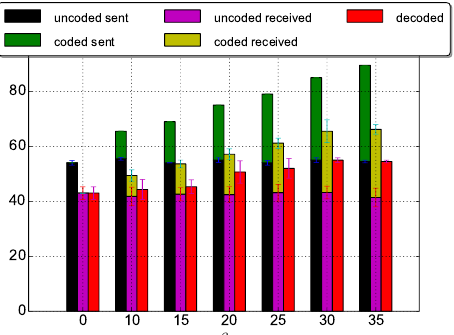
Figure 14. Decoding performance. The decoded packets is the total number of packets retrieved at the gateway that will be reassembled to re-constitute the